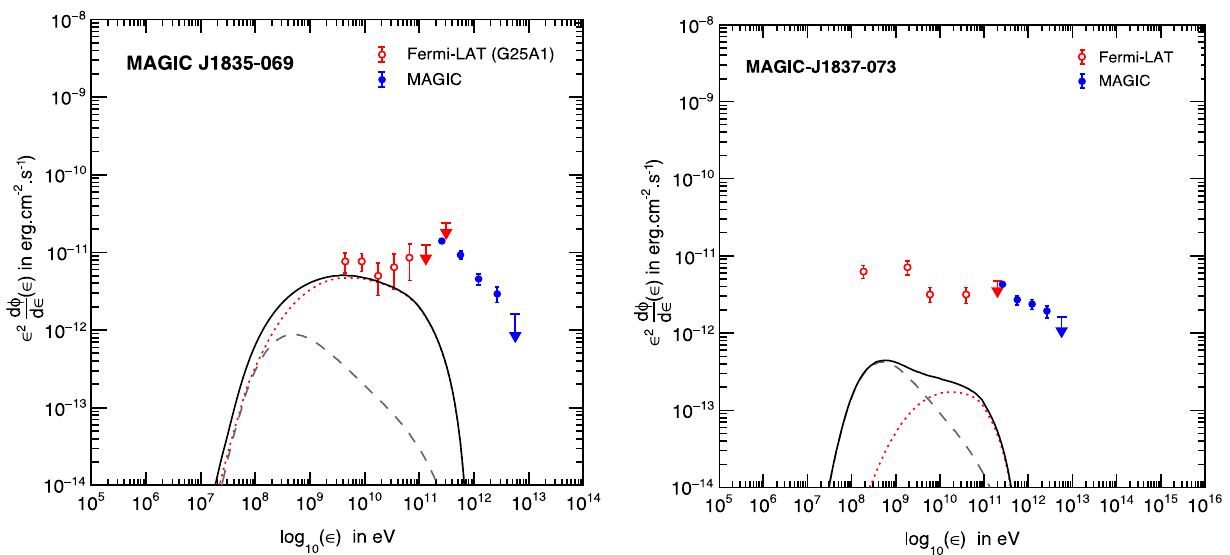
Fig. 3 Left: The estimated gamma-ray flux reaching the Earth from the MAGIC J1835-069. The red dotted line represents the correspond- ing gamma-ray flux produced due to interaction of SNR accelerated cosmic rays with the molecular cloud. The gray dotted line denotes the corresponding background gamma-ray flux from MAGIC J1835-069 produced due to interaction the Cosmic rays galactic background with molecular cloud. The black continuous line represents the estimated overall differential EM SED from the MAGIC J1835-069. Right: the